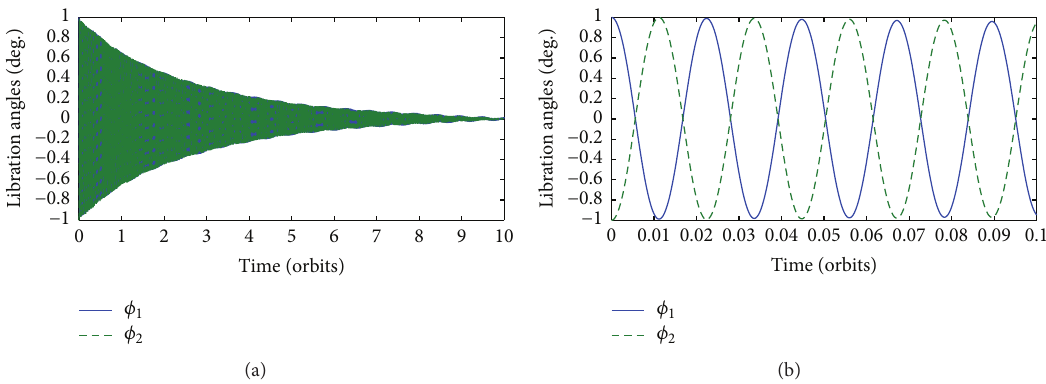
Figure 16: Libration angles from the formulations based on point 𝐴 by applying the SDRE control with 𝛼 = 0 for (a) the first 10 orbits and (b) the first 0.1 orbits.